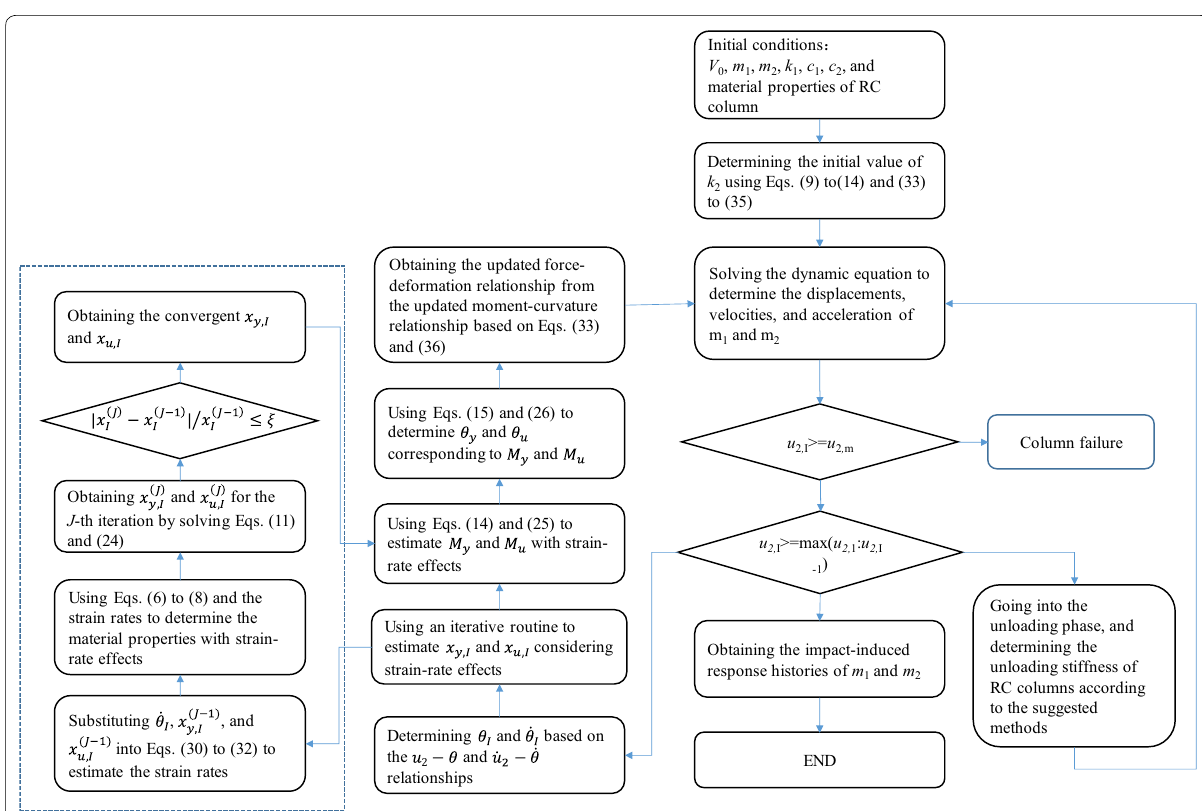
Fig. 6 Flowchart to determine impact responses of axially-loaded RC columns based on the simplified two-DOF